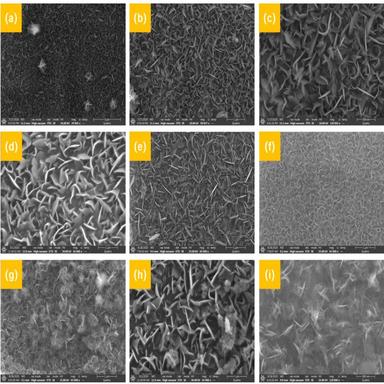
SEM images of the (a-c) Zn0.25Ni0.75Co-LDH-BA– , (d) Zn0.25Ni0.75Co-LDH-AA– , (e) Zn0.25Ni0.75Co-LDH-NO3 – , (f) Zn0.5Ni0.5Co-LDH-NO3 – , (g) Zn0.75Ni0.25Co-LDH-NO3 – , (h) NiCo-LDH-NO3 – , and (i) ZnCo-LDH-NO3 – .